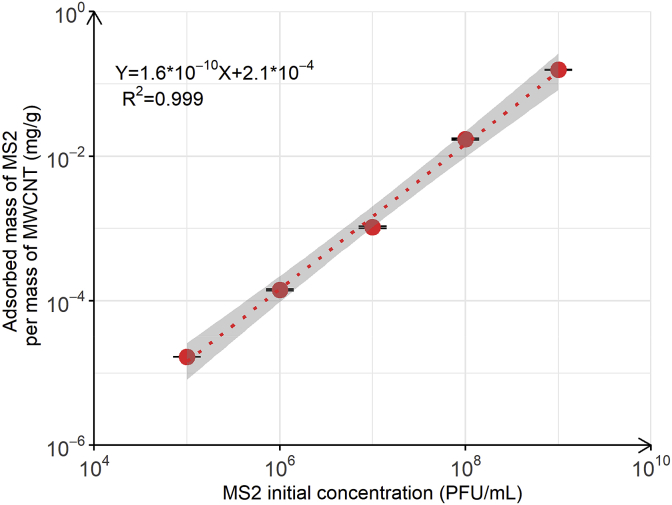
MS2 adsorbed mass per mass of MWCNT as a function of MS2 initial concentration ranging from 105 to 109 PFU/mL. The batch experiments were performed in duplicate at pH 7.7 with a fixed MWCNT mass of 15 mg. The red dotted line corresponds to the single linear regression. The grey zone corresponds to the 95% confidence interval of the linear regression fit. Error bars represent laboratory precision calculated using a pooled standard deviation, or weighted average of standard deviations calculated for all groups of samples, from the sets of duplicate samples. (For interpretation of the references to colour in this figure legend, the reader is referred to the Web version of this article.)